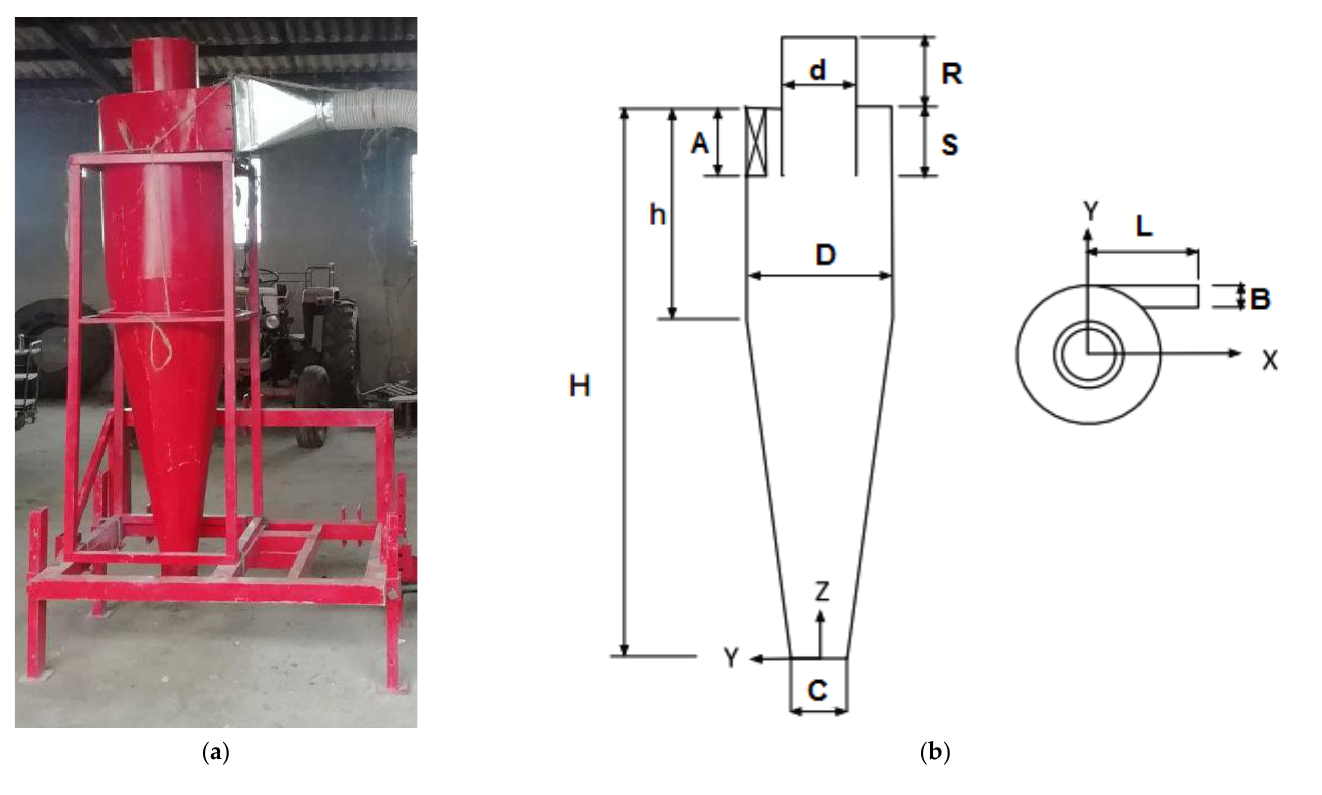
Figure 1. ( a ) Schematic of used cyclone in experiments, ( b ) dimensions of cyclone. Table 1. Cyclone separator dimensions.